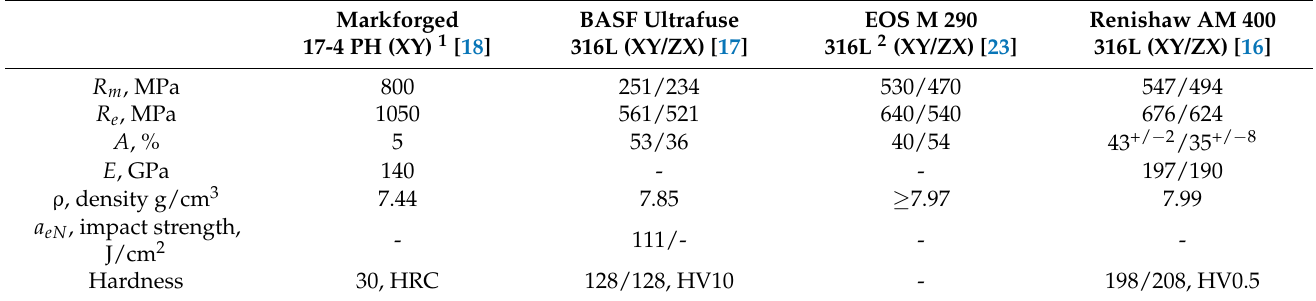
Figure 6. Envelope stress–strain curves (engineering stress versus engineering strain). Plots were created based on performed tensile tests considering all specimens. Table 6. Material properties as indicated by the manufacturer’s data